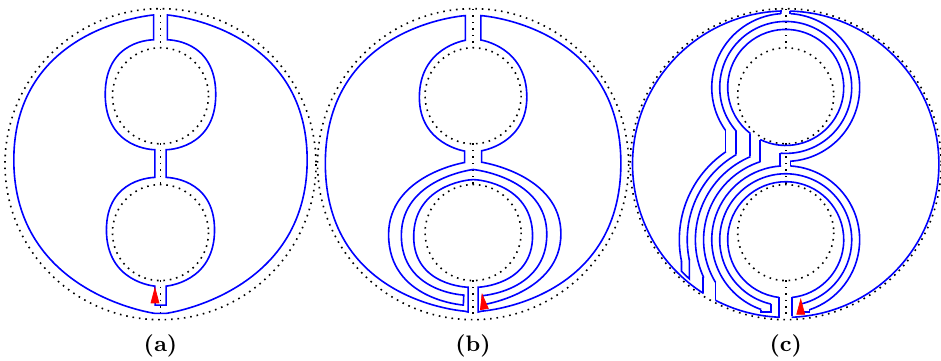
Figure 30. Starting from the red arrows, the blue curves indicate paths of the form P 1 (cid:11) 2(cid:22) (cid:11) (cid:17) P 1 (cid:1) P (cid:11) (cid:1) P 2 (cid:1) P (cid:0) 1 for (cid:13) (cid:11) = id ((cid:12)gure 30a), (cid:13) (cid:11) = (cid:13) (cid:0) 1 (cid:11) the marked graph in (cid:12)gure